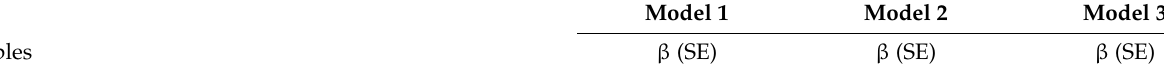
Table 2. Logistic binary regression for the effect of entrepreneur’s social identity on the desire for control.